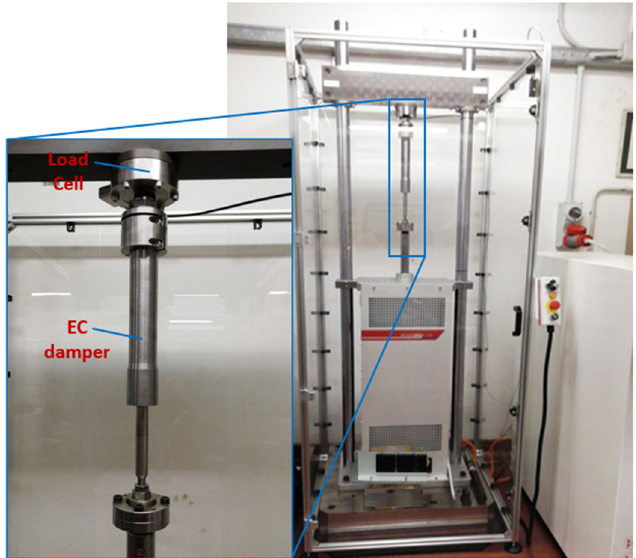
Figure 5. The Laboratory test rig used to experimentally validate the EC damper FE model prototype.